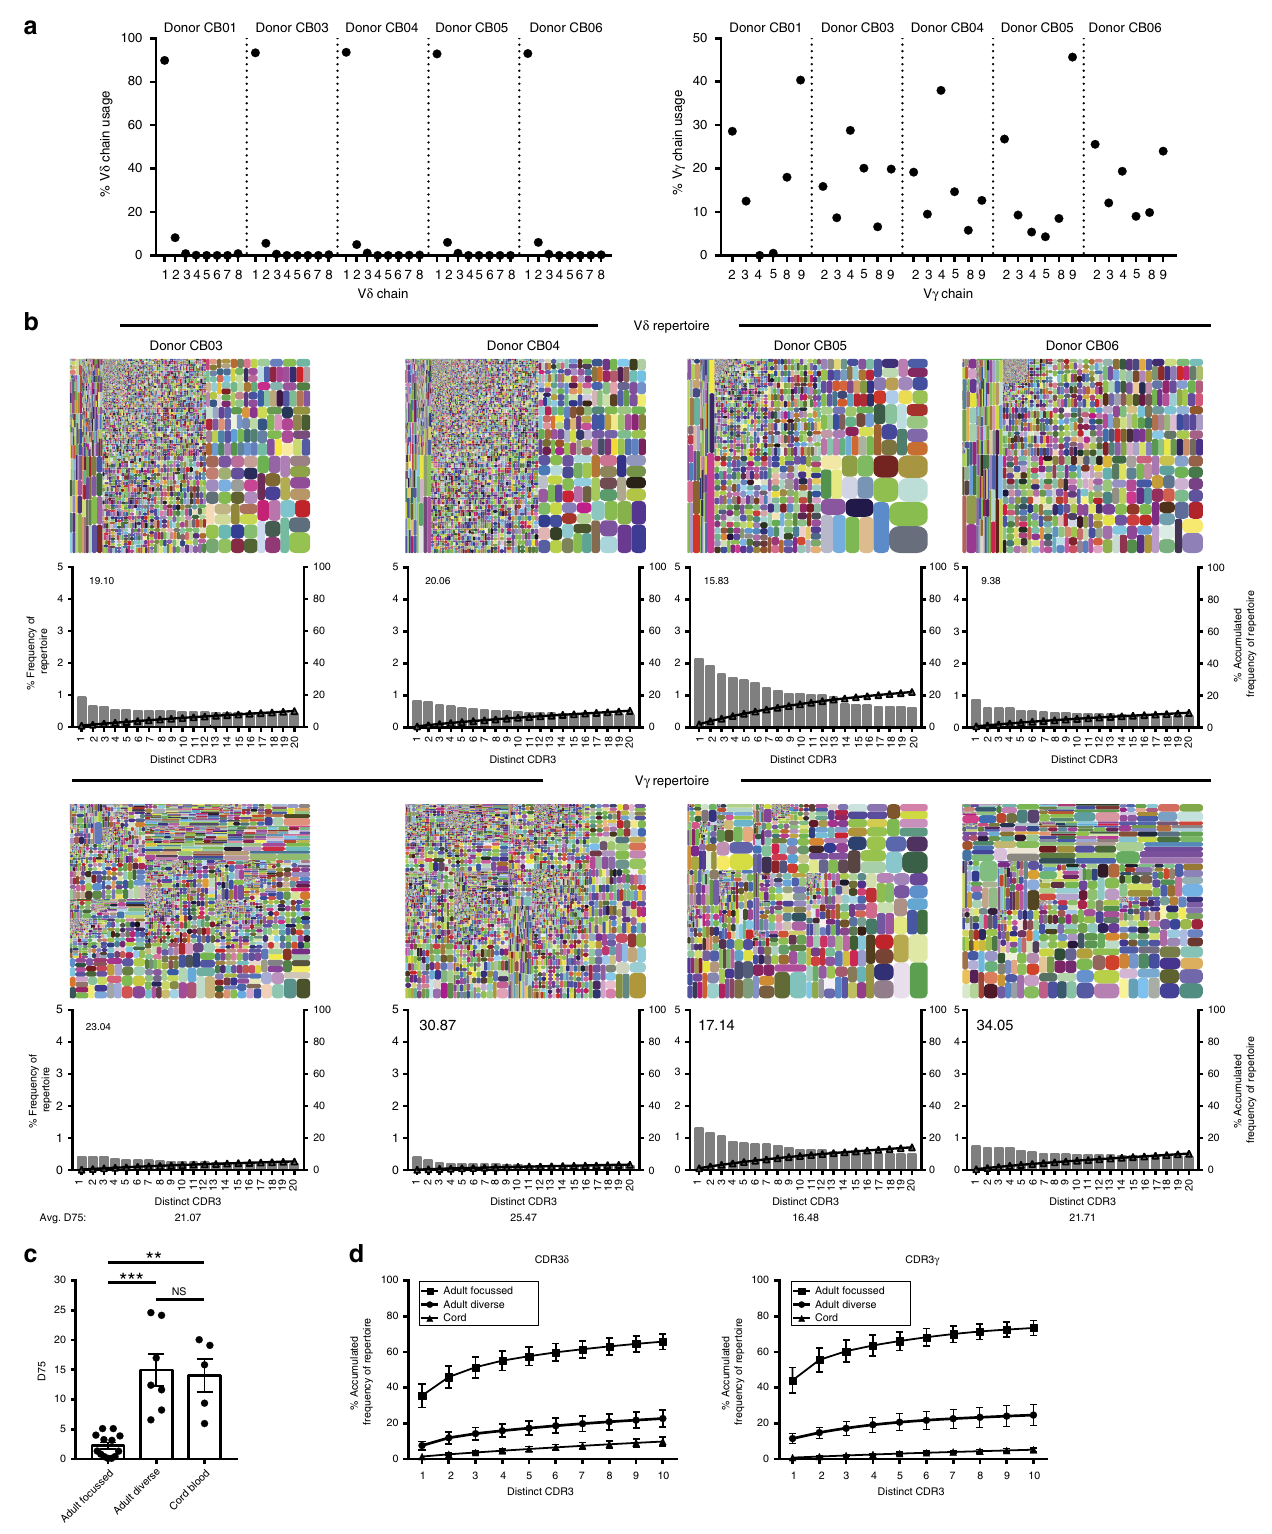
Figure 3 | The cord blood V d 1 þ TCR repertoire is composed of an unfocused set of cd TCRs. ( a ) V g and V d chain usage by sorted V d 1 þ Tcells from cord blood samples. ( b ) Tree maps for both CDR3 g and CDR3 d clonotype usage in relation to repertoire size and accumulated frequency graphs for each of the top 20 most prevalent clonotypes. ( c ) Comparison of mean ± s.e.m. of TCR d D75 values from adult focused ( n ¼ 13), adult unfocused ( n ¼ 7) and cord blood ( n ¼ 5) donors. ( d ) Accumulated frequencies means ± s.e.m. occupied by the first 10 clonotypes for each donor and grouped into adult focused donors ( n ¼ 13), adult diverse ( n ¼ 7) and cord blood ( n ¼ 5). Data were analysed by Kruskal–Wallis ANOVA with Dunn’s post-test comparisons, ** P ¼ 0.0049 and *** P ¼